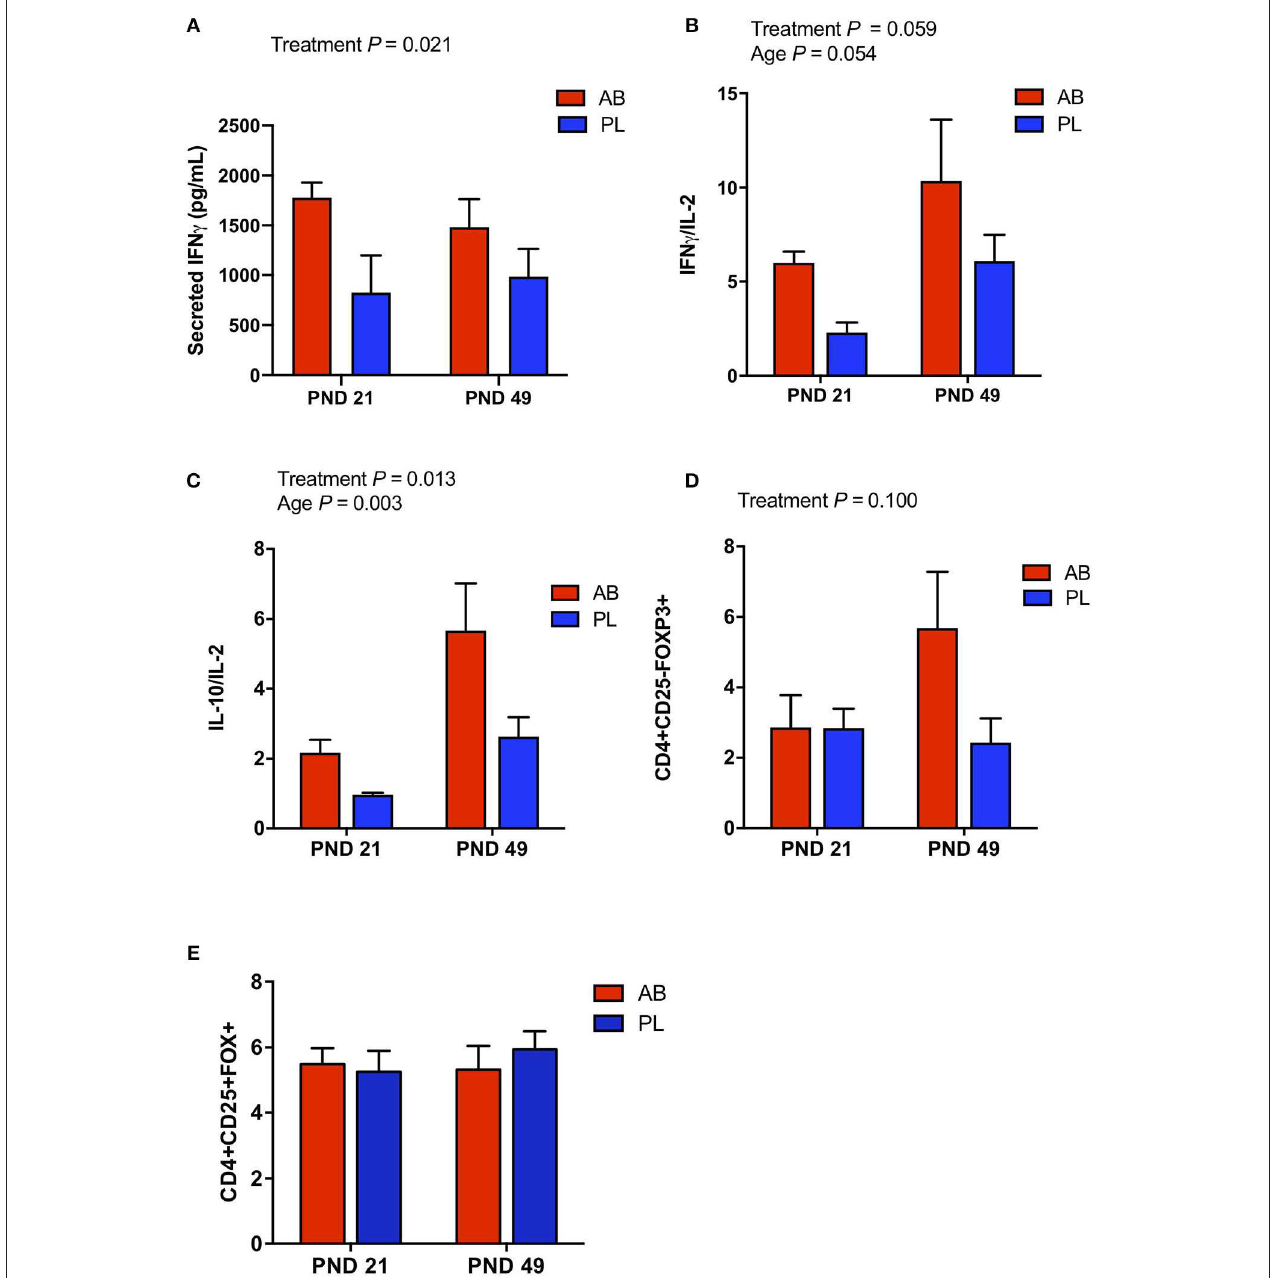
FIGURE 1 | In vitro cytokine secretion and cell sub-populations of PBMC were affected by antibiotic (AB) treatment. PBMCs from AB and placebo (PL) treated pigs were stimulated in vitro with phytohaemagglutinin (PHA), a T cell mitogen. (A) Secreted IFN γ was higher in AB vs. PL treated pigs (Two-way ANOVA, Treatment P = 0.006, Age P = 0.022, Interaction P = 0.472). (B) The ratio of IFN γ /IL-2 tended to be higher in AB vs. PL treated pigs and tended to increase with age (Two-way ANOVA, Treatment P = 0.059, Age P = 0.054, Interaction P = 0.780). (C) The ratio of IL-10/IL-2 was higher in AB vs. PL treated pigs and increased with age (Two-way ANOVA, Treatment P = 0.013, Age P = 0.003, Interaction P = 0.248). (D) In addition, immune cell subpopulation CD4 + CD25-FoxP3 + , identified by flow cytometry, tended to be higher in AB treated pigs (Two-way ANOVA, Treatment P = 0.100, Age P = 0.220, Interaction P = 0.106. (E) However, the CD4 + CD25 + FoxP3 + immune cell subpopulation was not affected by treatment or age (Two-way ANOVA, Treatment P = 0.752, Age P = 0.684, Interaction P = 0.500). PND 21: AB n = 7, PL n = 7; PND 49: AB n = 7, PL n = 8; PND 84: AB n = 8, PL n = 7.